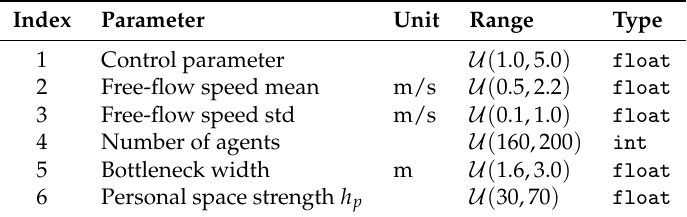
Table 1. Uncertain parameters and their distribution used for the sensitivity